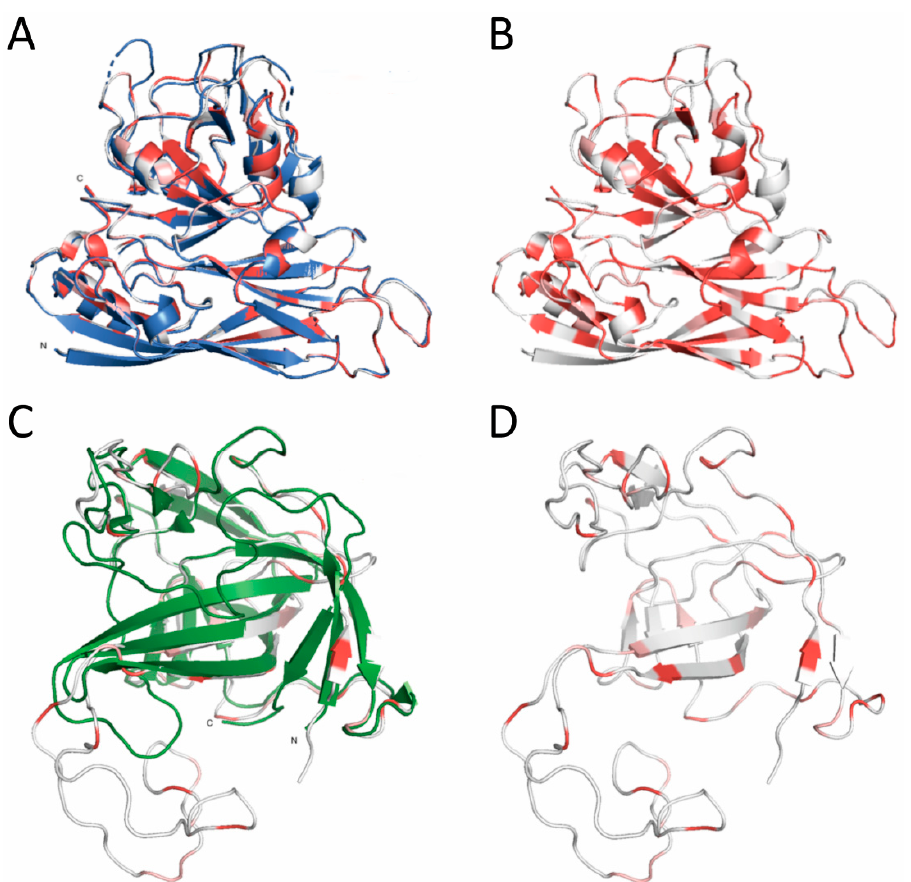
Figure 6. Alignment of classical HAstV-1 capsid structures with VA1 homology models. Crystal structure of the HAstV-1 (blue and green) aligned with homology models of VA1 capsid core ( A ) and spike ( C ). VA1 models ( B , D ) were marked with different colors based on its similarity with HAstV-1 reference: residues that are perfectly conserved (red), residues that are not perfectly conserved but that have a BLOSUM62 score higher than 0 (pink) and residues with a BLOSUM62 score lower than 0 or residues that are aligned to a gap in the reference (white).